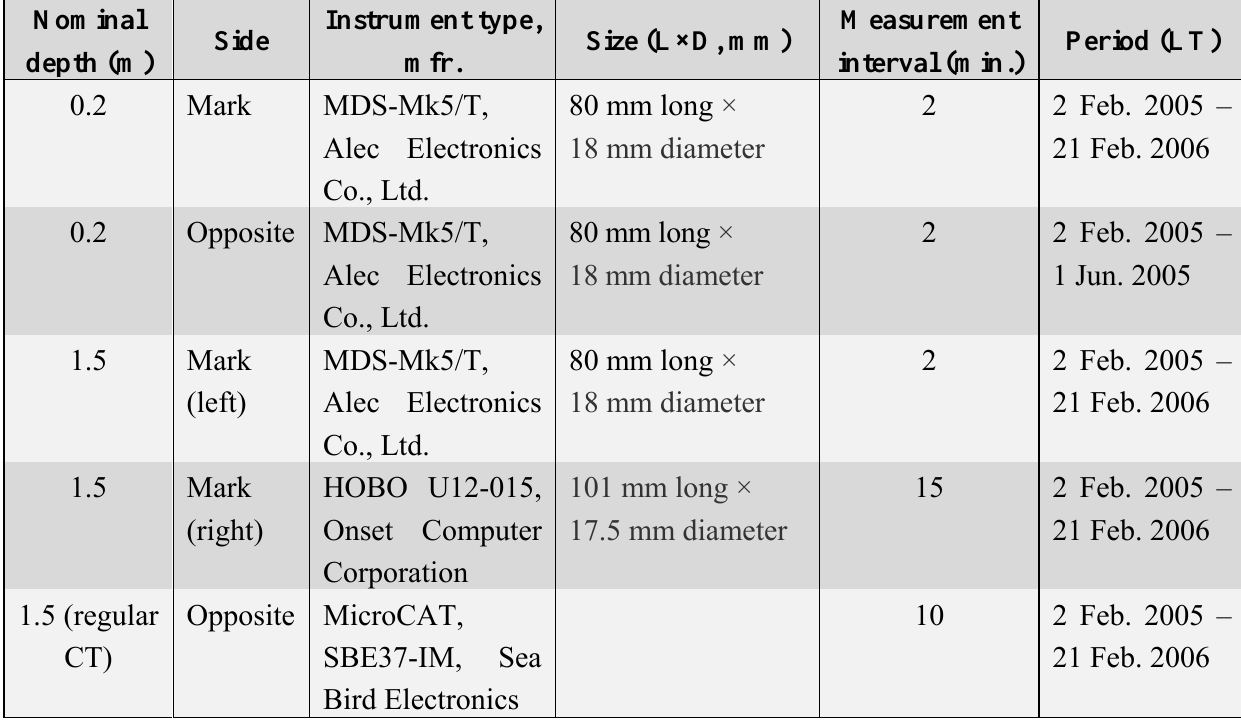
Table 1. Thermometers used in this study and their positions on the TRITON buoy